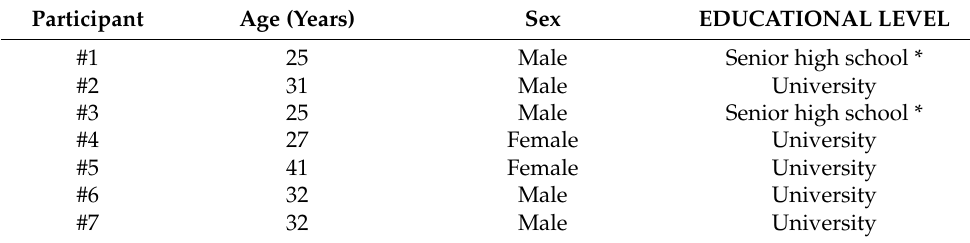
Table 4. Participant characteristics for SUS.